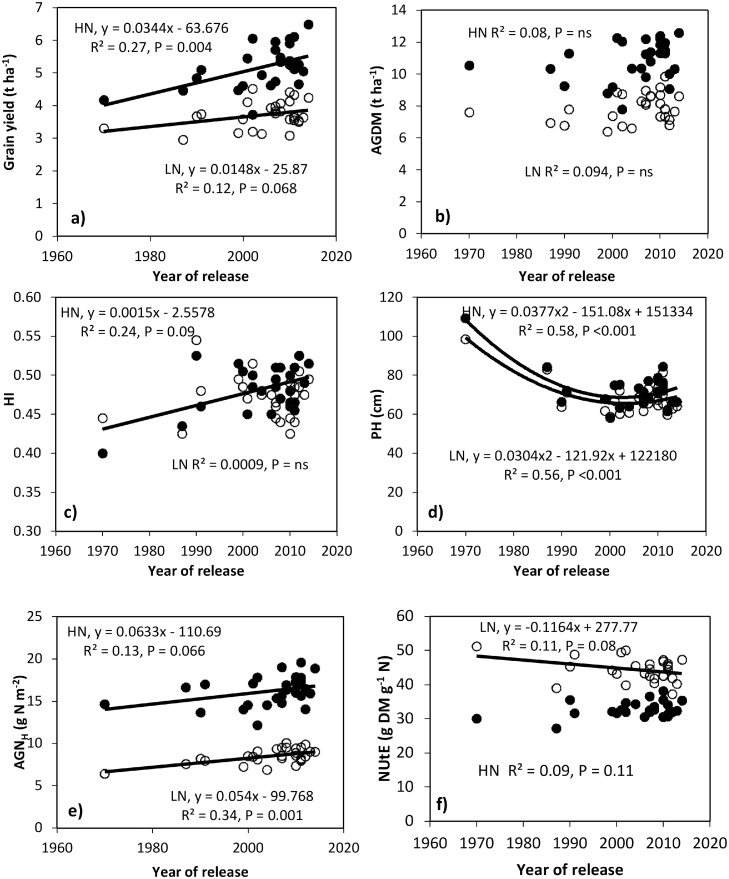
Regression of year of release on (a) grain yield (100% DM), (b) above-ground DM, (c) harvest index, (d) plant height (e) above-ground N at harvest (AGNH) and (f) N-utilization efficiency (NUtE) in HN and LN treatment for 28 Indian bread wheat cultivars released 1970–2014 (values are means of 2013-14 and 2015-16). (HN treatment ●; LN treatment ○).